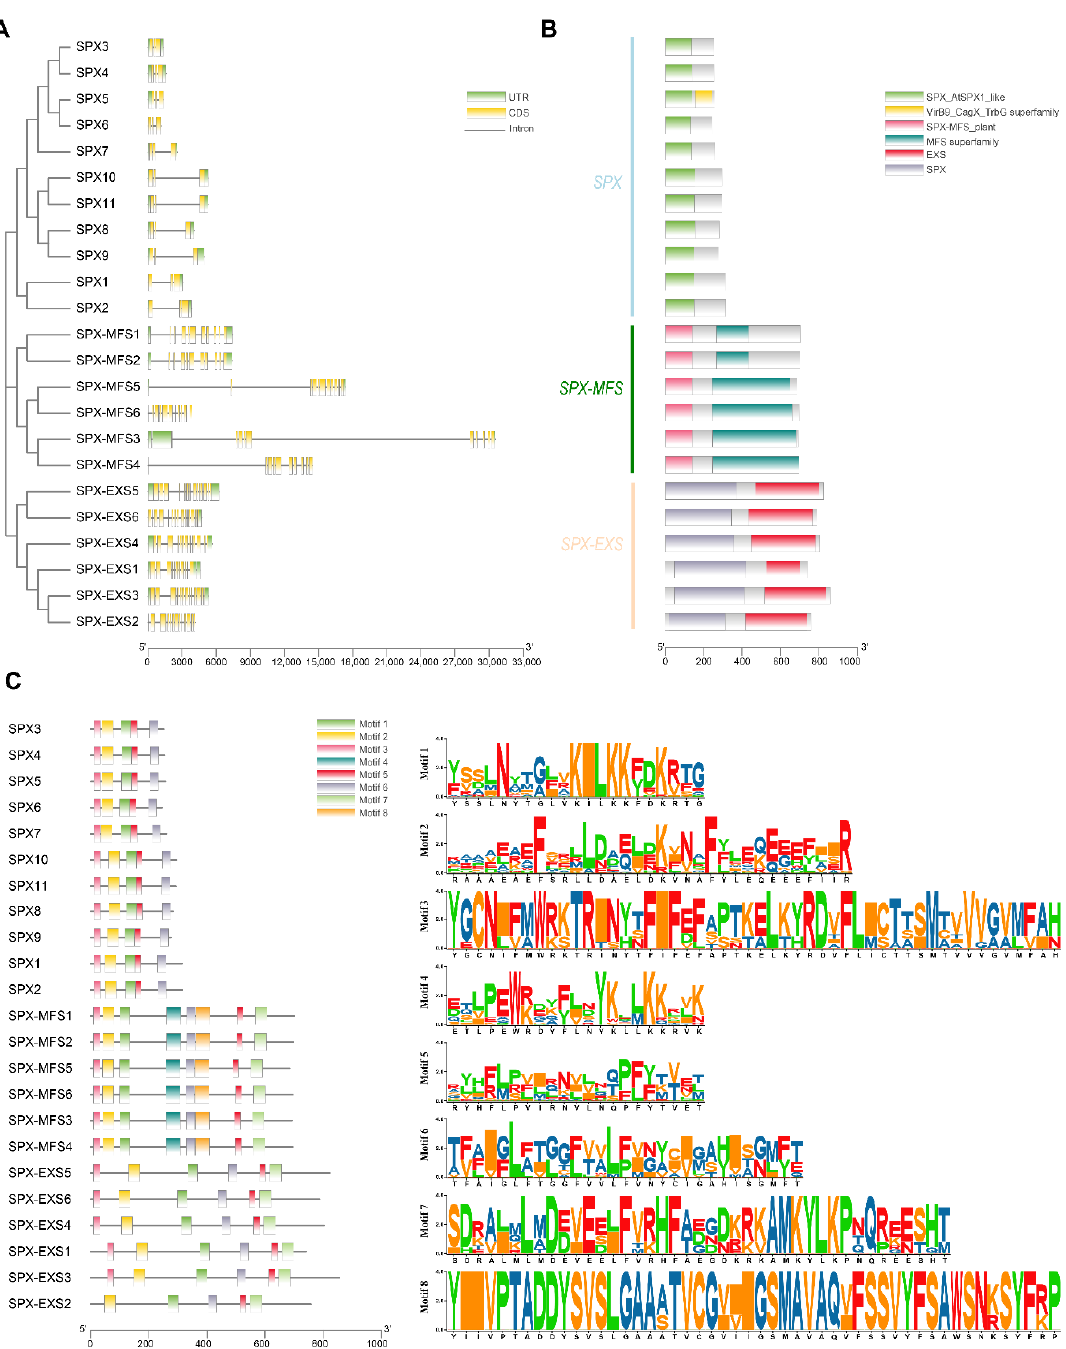
Figure 3. Gene structure, motifs, and conserved structural domains analysis of the PeSPXs in Phyllostachys edulis . ( A ) Intron-exon structure of the PeSPX genes. Yellow boxes, black lines, and green boxes represent exons (CDS), introns, and the 5 ′ and 3 ′ untranslated regions, respectively. ( B ) Predictions of the conserved domain in 23 PeSPX proteins. The length of each protein sequence is represented by the gray bars, and colored boxes represent conserved domains. ( C ) Distribution of the conserved motifs in PeSPX proteins. The scale bar at the bottom indicates the protein lengths, and sequence logos for each conserved motif are shown on the right. Visualized by TBtools (v1.108) (https://github.com/CJ-Chen/TBtools/releases (accessed on 12 November 2022)).